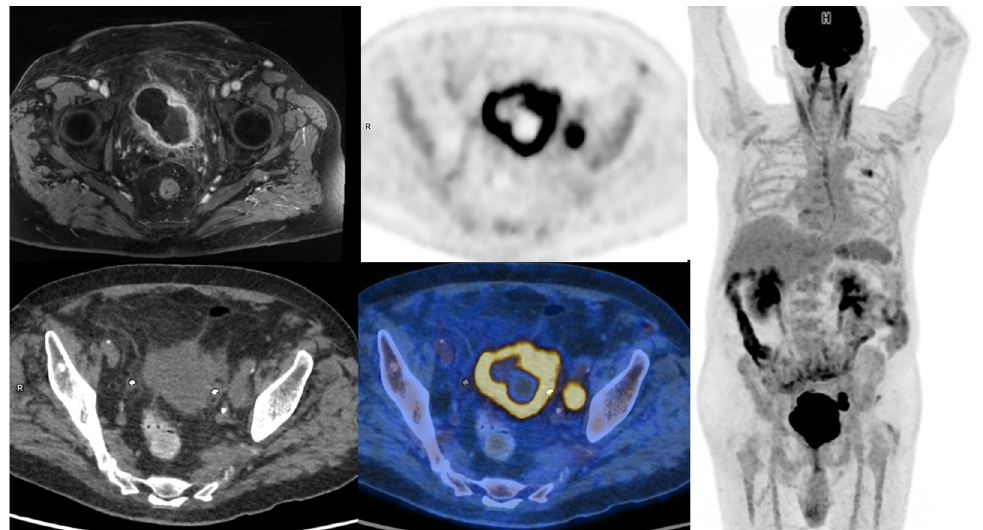
Figure 1. 65-year-old patient with a locally advanced MIBC. Up and left: T1 fat-sat after gadolinium contrast media injection MRI sequence, showing an abnormal enhancement of peri-vesical fat (local stage T3b). Other: PET, CT, and PET/CT fused images revealed a necrotic bladder mass associated with a supra-centimetric ilio-obturator adenopathy on the left side, both with intense FDG uptake. No extra-pelvic lesion was seen (MIP showing focal uptake in the left lung of infectious origin). The patient was managed with first-line chemotherapy, followed by surgery after a good response to treatment.